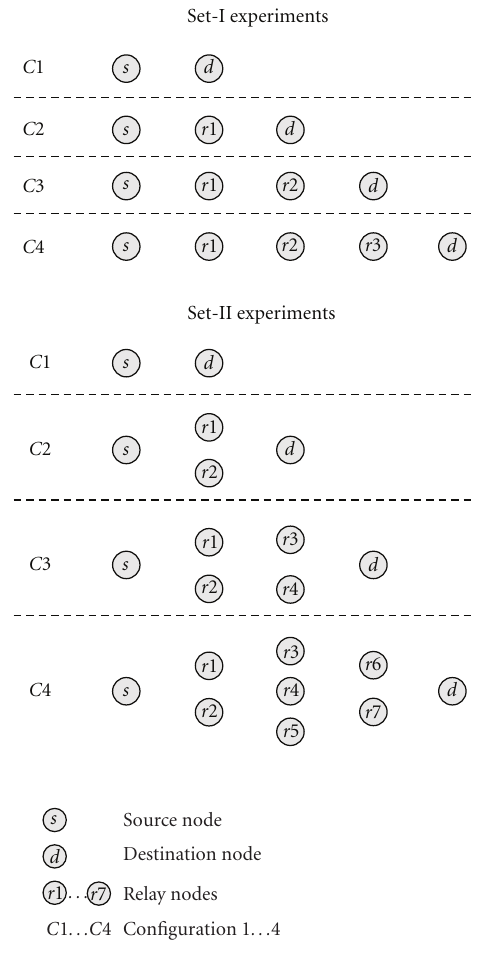
Figure 12: Illustration of the two sets of experiments.